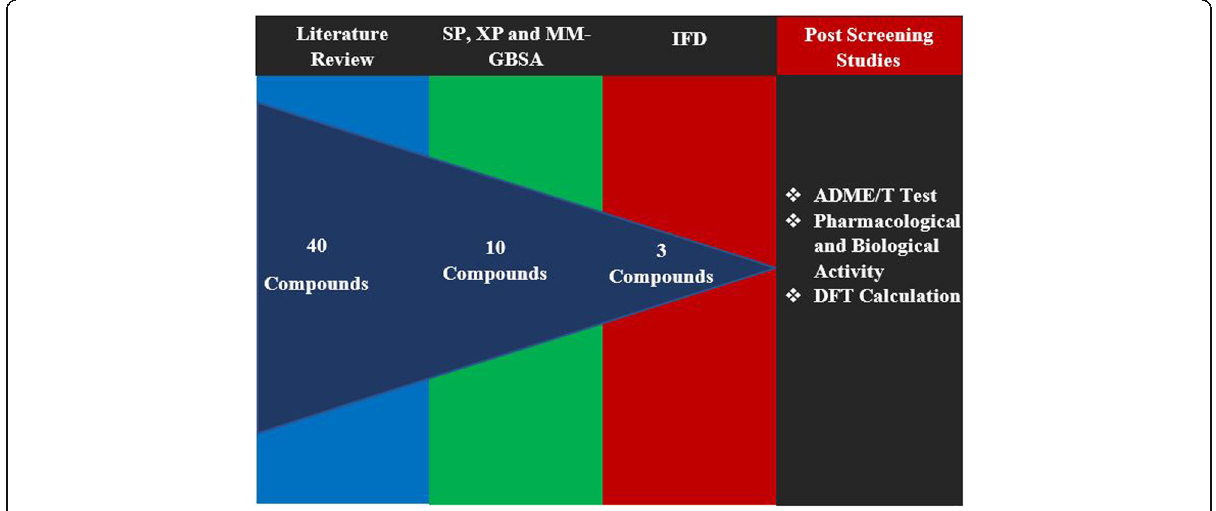
Fig. 2 Strategies employed in this study to select best β -secretase